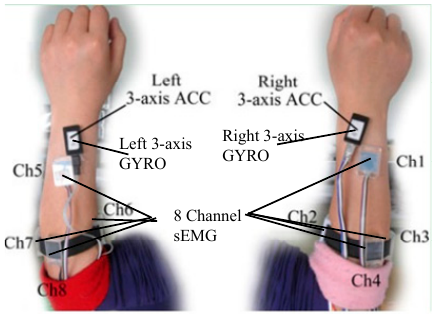
Figure 2. The location of sEMG, ACC, and GYRO sensors on the forearms [16].